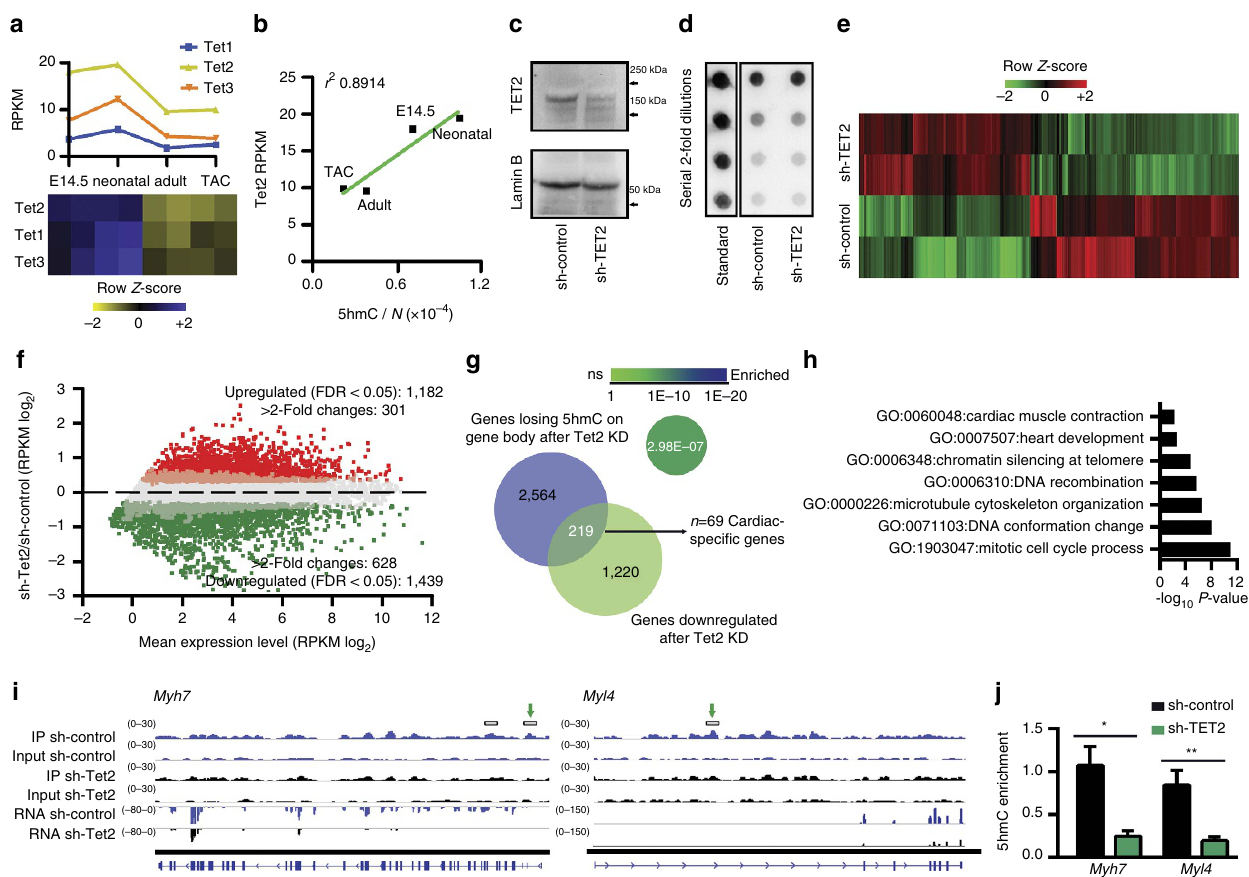
Figure 6 | Involvement of TET2 in cardiac hydroxymethylcytosine deposition. ( a ) Transcript abundance during cardiac maturation and hypertrophy for the three TET family genes, assessed by RNA-seq. ( b ) Plot showing the positive correlation between the absolute content of 5-hmC (5-hmC/N), assessed by liquid chromatography–mass spectrometry and Tet2 RNA expression (RPKM). ( c ) Expression of TET2 protein in CMCs expressing sh-Tet2 or sh-control. Embryonic CMCs were transduced with a lentiviral vector expressing a previously validated sh-Tet2 or a scrambled sequence (sh-control) and harvest 72h after transduction. Lamin B was used to assess loading. Representative blot shown. Full-length blot is presented in Supplementary Fig. 10. ( d ) Dot blot analysis of genomic 5-hmC after KD of Tet2 . ( e ) Heat map of hierarchical clustering of 1,182 upregulated and 1,439 downregulated genes after Tet2 RNA KD, measured by RNA-seq on two biological replicates for each condition. ( f ) Comparison of gene expression (RNA-seq) in CMCs expressing sh-control or sh- Tet2. Shown is a summary dot plot, with red dots representing upregulated genes and green dots representing downregulated genes ( n ¼ 2 samples each; q -value r 0.05). ( g ) Venn diagram showing the overlap in the number of genes undergoing 5-hmC loss exclusively on the GB (exons plus introns) and downregulation of expression (RNA-seq) after Tet2 KD. Enrichment of genes within the MGI cardiovascular expression database, calculated using Fisher’s exact test. ( h ) Enriched GO terms relative to the 219 genes in panel ( g ). GO analysis was conducted with Metascape 1.0 ( P -value r 0.01). ( i ) IGV profiles of 5-hmC MeDIP-seq and RNA-seq profiles of representative genes ( Myh7 and Myl4 ). DhMRs identified with MeDIPS are shown by boxes above the profiles. The scale for each track is given to the left. Exact locations of primers used to validate DhMRs are shown by green arrows. ( j ) Analysis of 5-hmC enrichment on Myh7 and Myl4 . Data are mean ± s.d. ( n ¼ 3). * P -value r 0.05; ** P -value r 0.01 (unpaired Student’s t